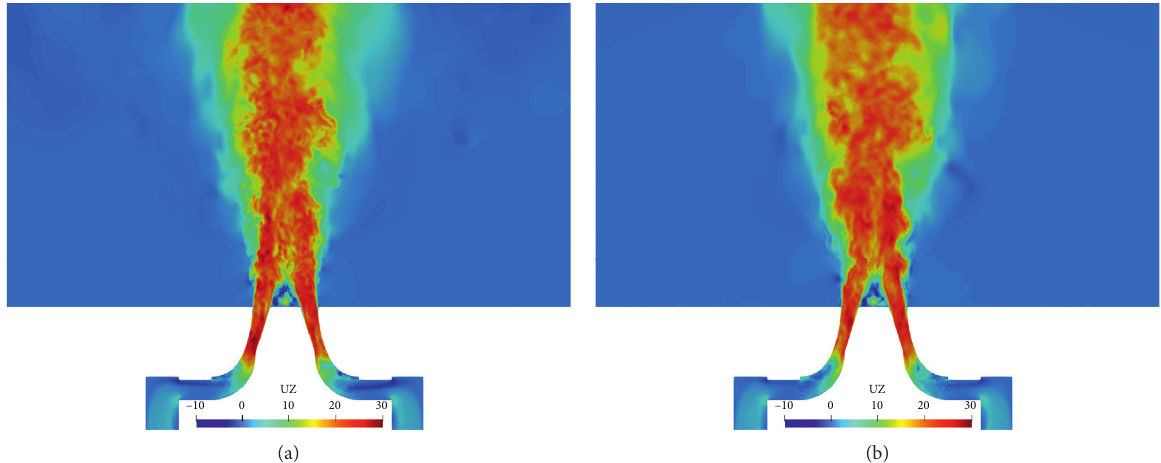
Figure 8: Instantaneous axial velocity fields for cases A-R (a) and B-R (b) in the central vertical